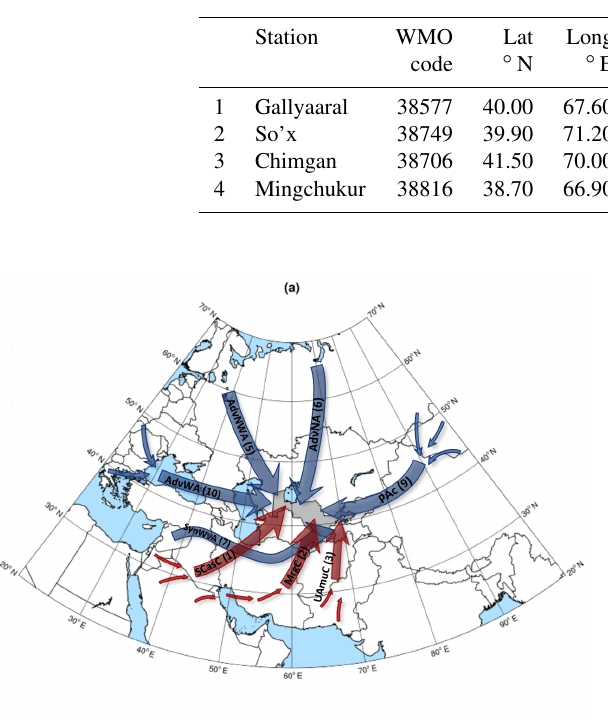
Table 2. The main characteristics of the meteorological stations in Uzbekistan used in this study (source: Uzhydromet)